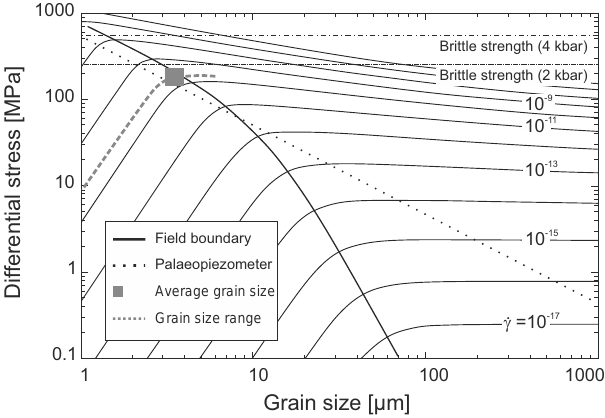
Figure 8. Deformation mechanism map for calcite at 300 ◦ C in the differential stress versus grain size space. Flow laws used are by Renner et al. (2002) for the dislocation creep field and Her- wegh et al. (2003) for grain size sensitive creep. Additionally, the palaeopiezometer (Schmid et al., 1980), the field boundary after De Bresser et al. (1998, 2001) and the brittle strength (Byerlee, 1978) are plotted. The rectangle represents the average grain